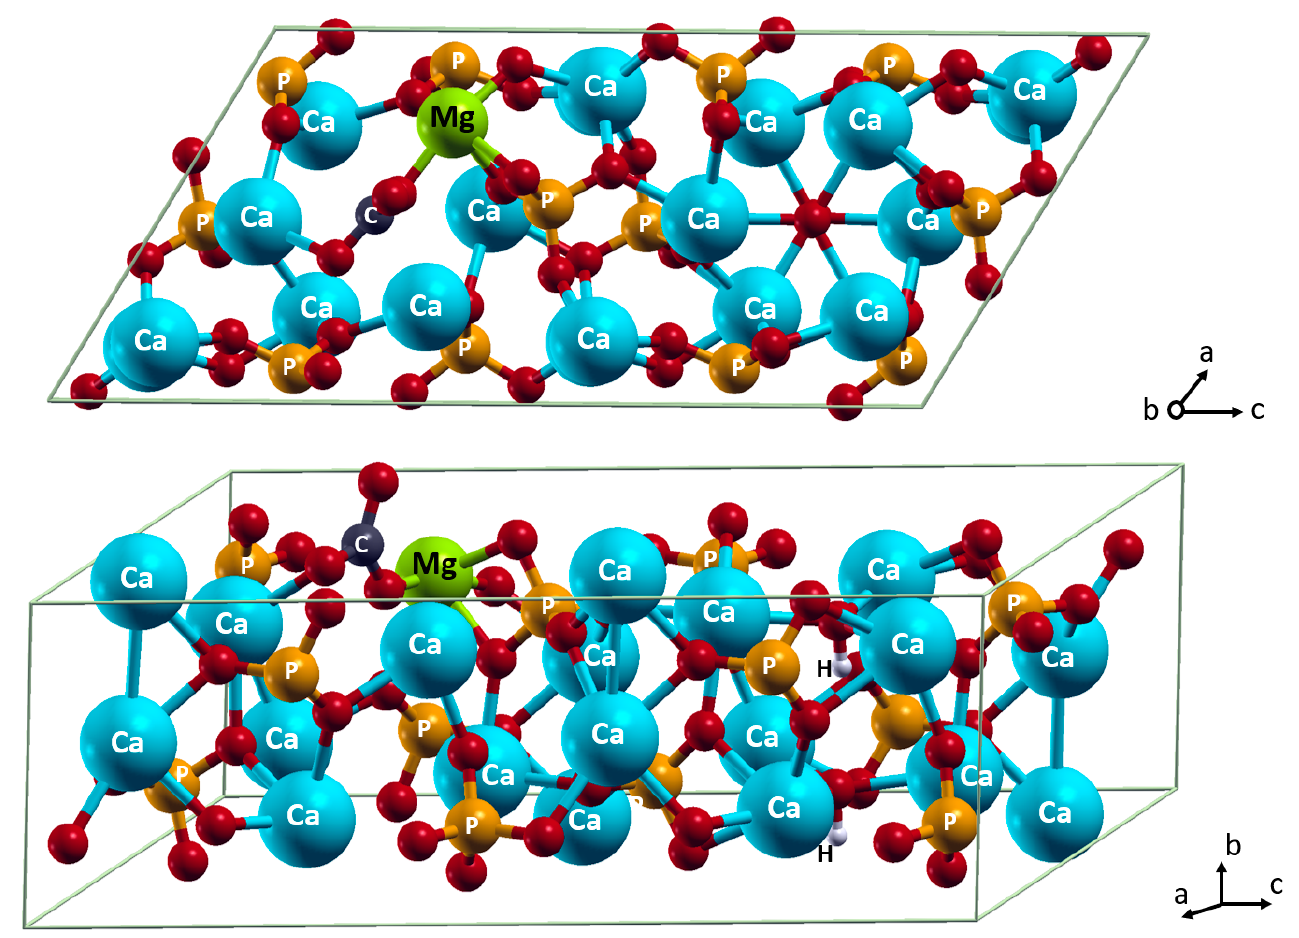
Figure 4. Incorporation of Mg 2+ in Ca(2) position and CO 32 − in A position. Color coding: Ca–cyan; P–orange; O–red; H–white; C–dark grey; Mg–light green. For clarity, all atoms except oxygen are named.